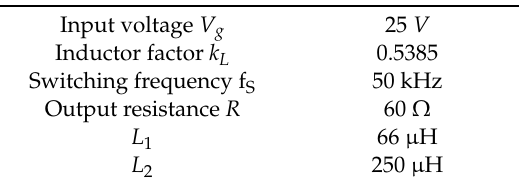
Table 5. Performance of the former strategy and the proposed method.